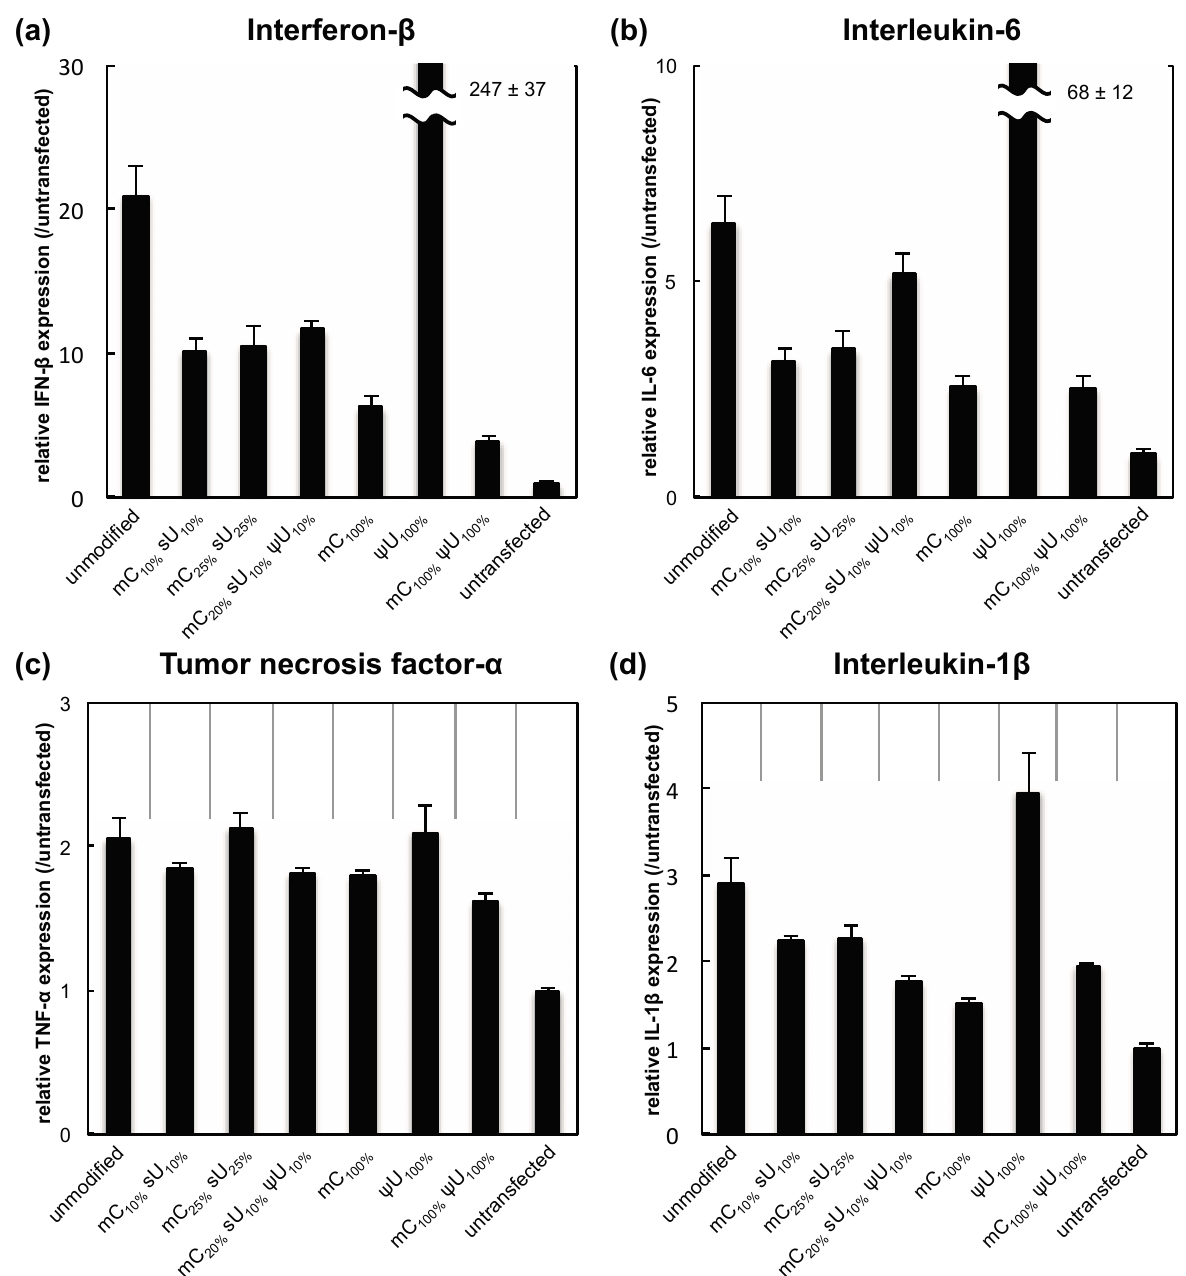
Figure 1. Inflammatory response after mRNA introduction into RAW264.7 cells. mRNA- encoding GLuc was introduced to RAW264.7 cells using Lipofectamine™ LTX. After 4 h, expression of inflammatory molecules was measured with qRT-PCR. ( a ) Interferon- β (IFN- β ); ( b ) Interleukin-6 (IL-6); ( c ) Tumor necrosis factor- α (TNF- α ); and ( d ) Interleukin-1 β (IL-1 β ). Data are presented as the mean ± standard error of the mean (S.E.M.) ( N = 6) for expression levels relative to the untransfected